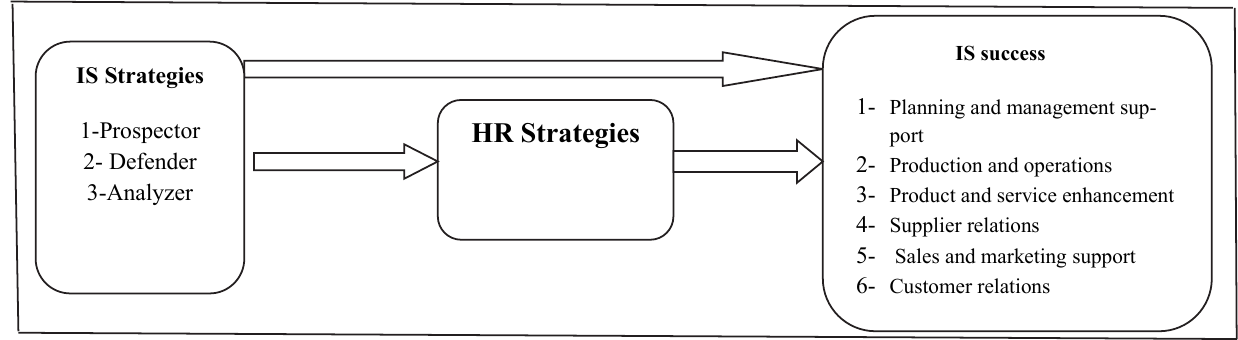
Fig. 1. The structure of the proposed study